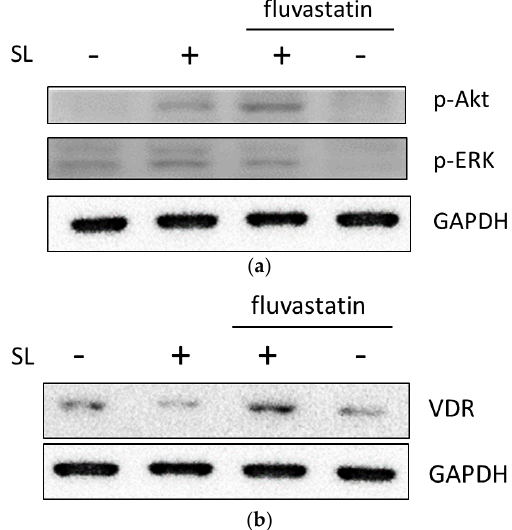
Figure 8. Effect of fluvastatin on the activation of intracellular signals in Salmonella -infected Caco-2 cells. Cultured Caco-2 cells were either uninfected or infected for 1 hour with S. Typhimurium wild-type strain SL1344 (SL) in the presence or absence of 1 μM fluvastatin. Cell lysates were analyzed by immunoblotting with antibodies to phosphorylated (p)-Akt and -ERK ( a ), and VDR ( b ) to evaluate the activation of Akt, ERK, and VDR protein expression. GAPDH was used for the normalization of the cytosolic proteins. Representative immunoblots are shown. The results shown are representative of three separate experiments.